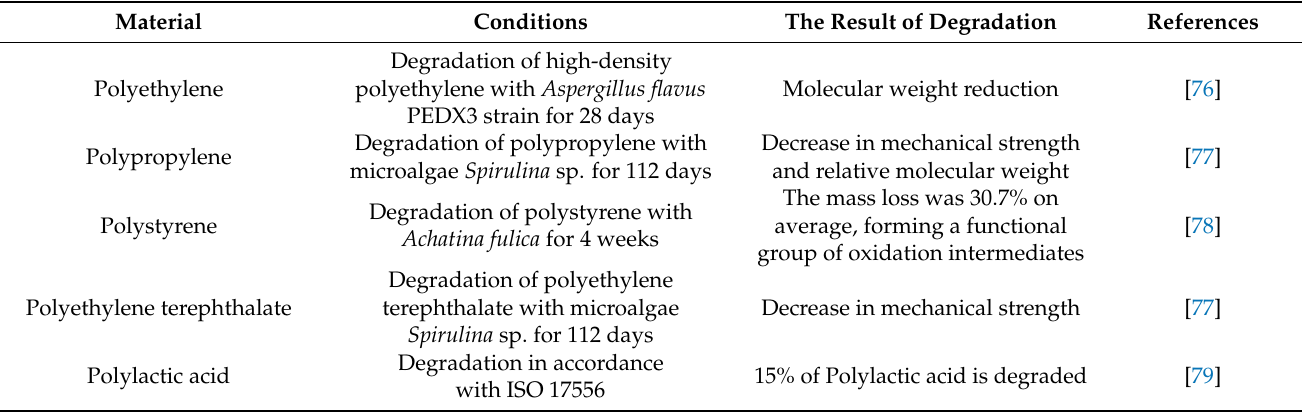
Table 3. Biodegradation of common plastics.